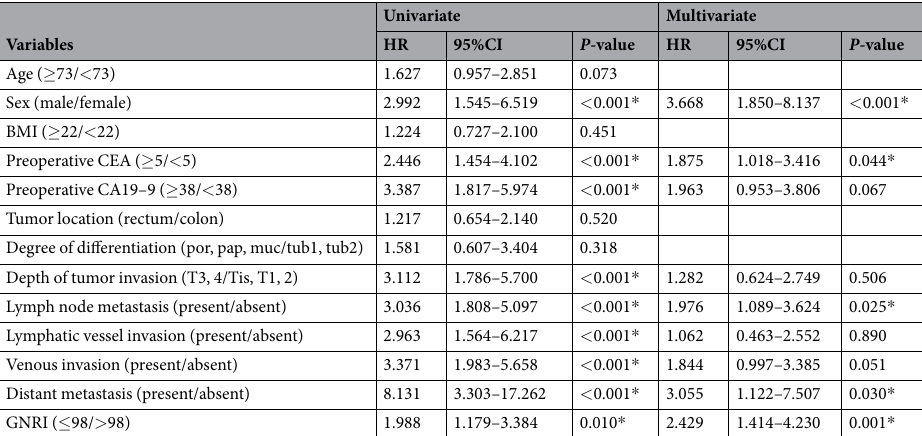
Univariate Multivariate HR 95%CI P -value HR 95%CI P -value